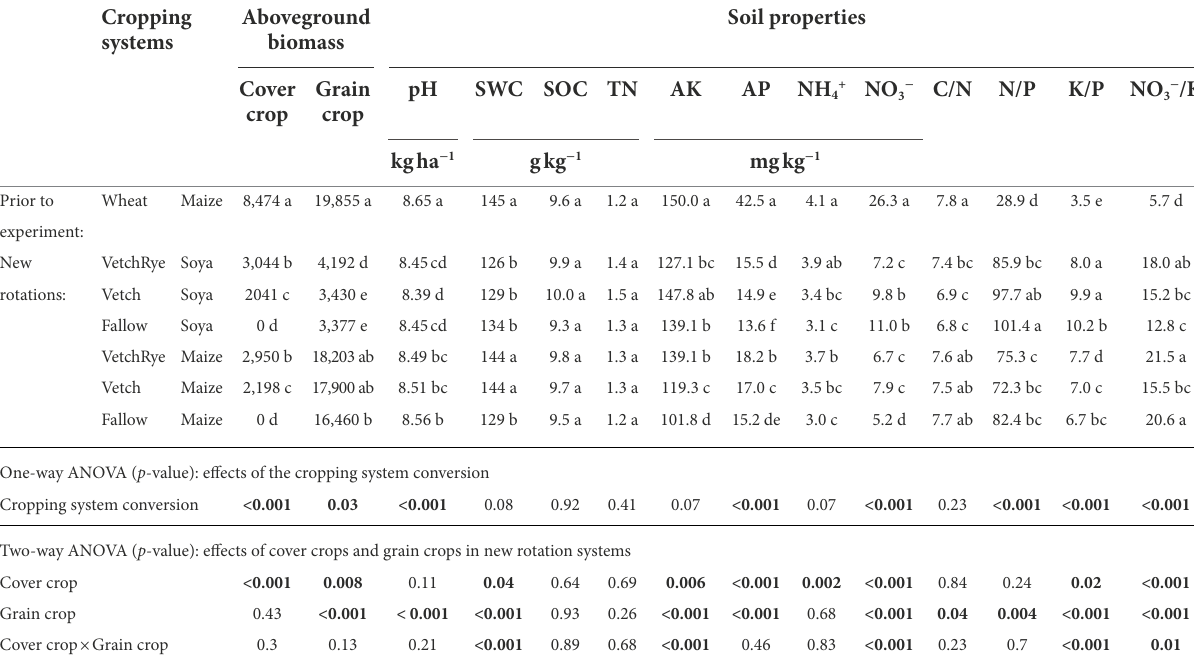
Lowercase letters in each column indicate significant differences among cropping systems at p ≤ 0.05. Bold numbers indicate significant effects at p ≤ 0.05. VetchRye is the mixture of vetch and rye. SWC, soil water content; SOC, soil organic carbon; TN, total nitrogen; AP, available phosphorus; AK, available potassium; C/N, the ratio of SOC and TN; N/P, TN, and AP; NO3 – /K, the ratio of soil nitrate and